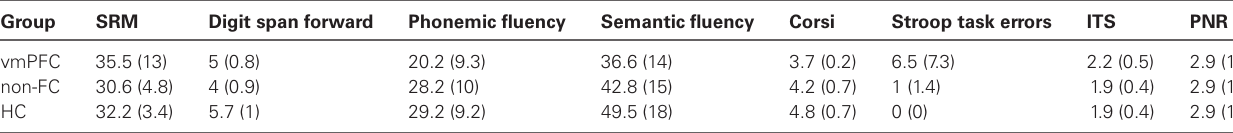
Table 2 | Results of selected neuropsychological tests [mean (standard deviation)] . Group